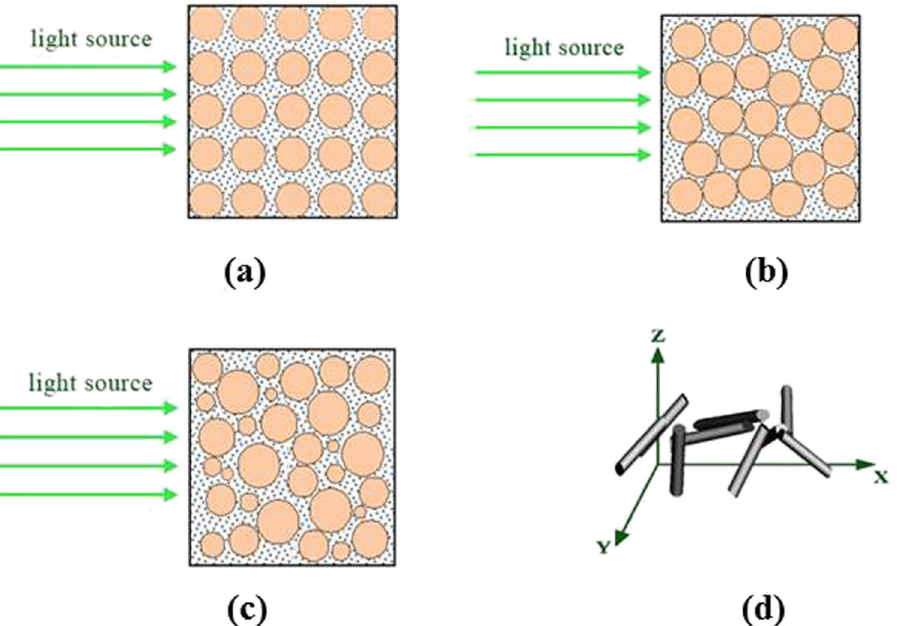
Figure 1: Illustration of the arrangement of carbon nano fi bers in nanocomposite: ( a ) uniform arrangement of carbon nano fi bers with radius of 6 μ m, ( b ) random arrangement of carbon nano fi bers with radius of 6 μ m, ( c ) random arrangement of carbon nano fi bers of with a radius range from 1 to 7 μ m and ( d ) 3D random arrangement of carbon nano fi bers.